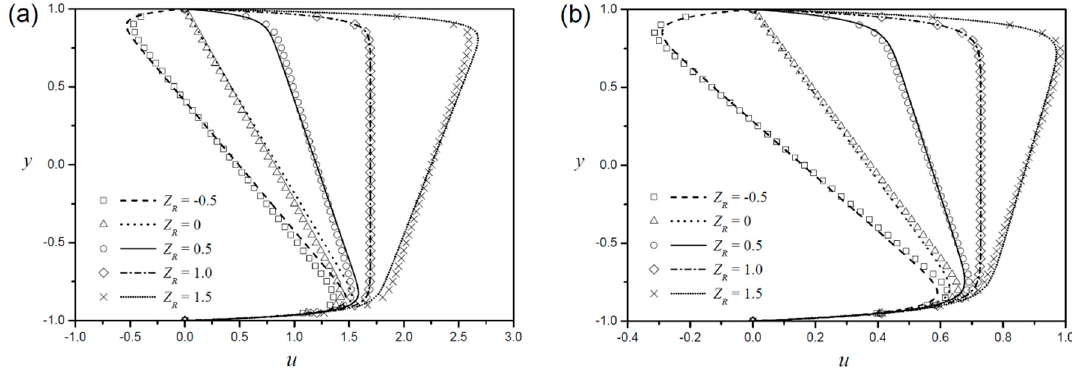
Figure 4. Velocity profiles according to different zeta potential ratios with a fixed Debye length ( (cid:1838) (cid:3005) = 0.05 ) for ( a ) shear thinning fluid ( (cid:1866) = 0.8 ) and ( b ) shear thickening fluid ( (cid:1866) = 1.2 ).